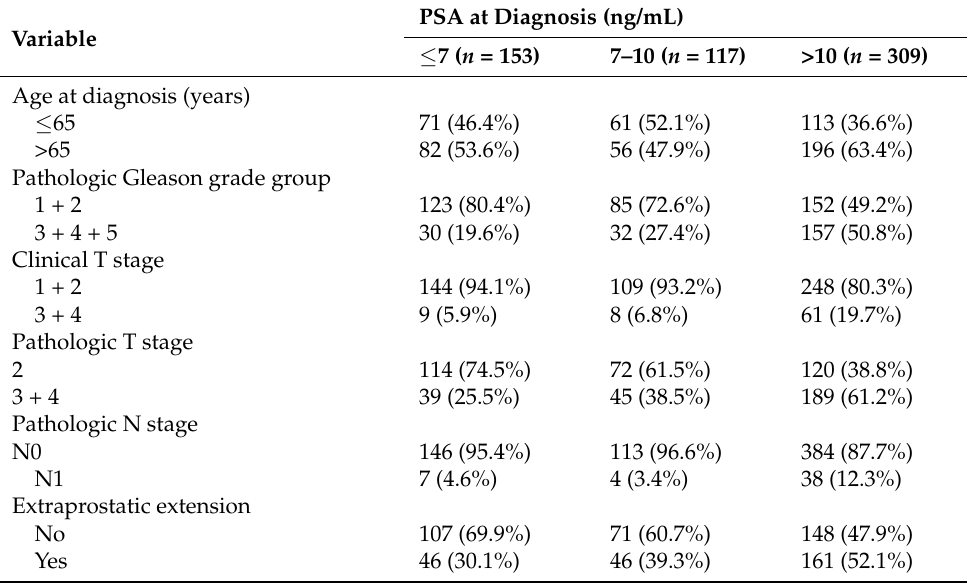
Table 1. Distributions of demographical characteristics in 579 patients with prostate